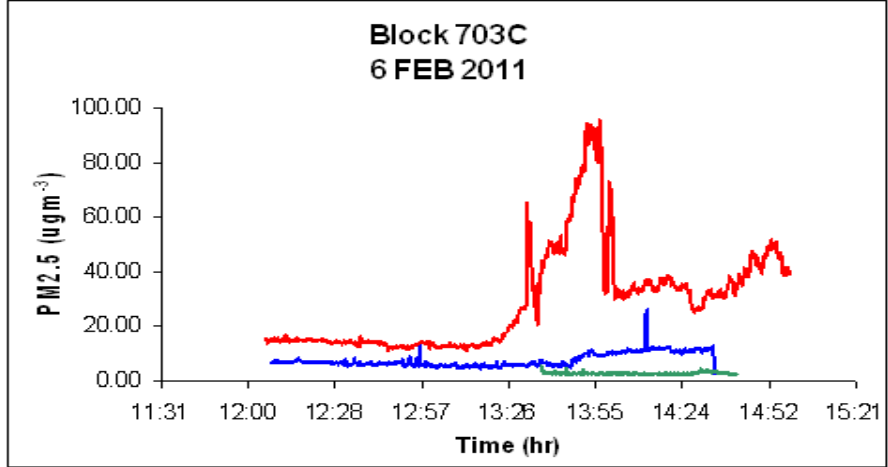
Figure 14. Measurements of PM (blue) and Site 3